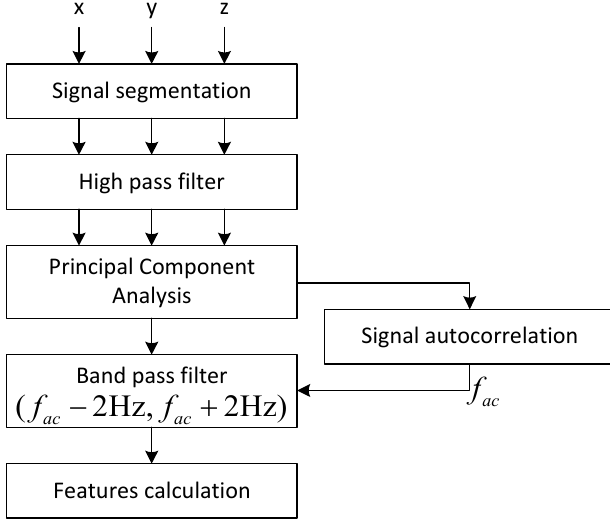
Figure 4. Tremor signal processing chain.